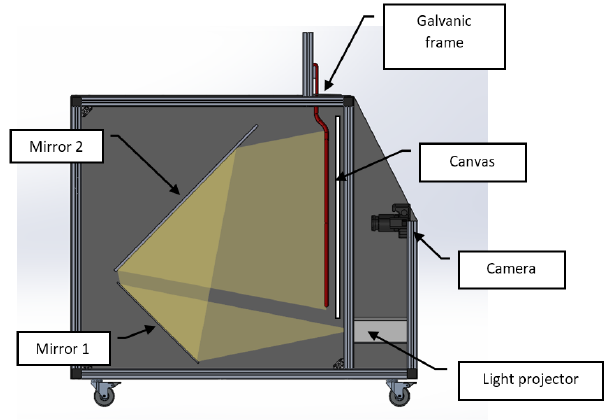
Figure 13. Counting system main components.